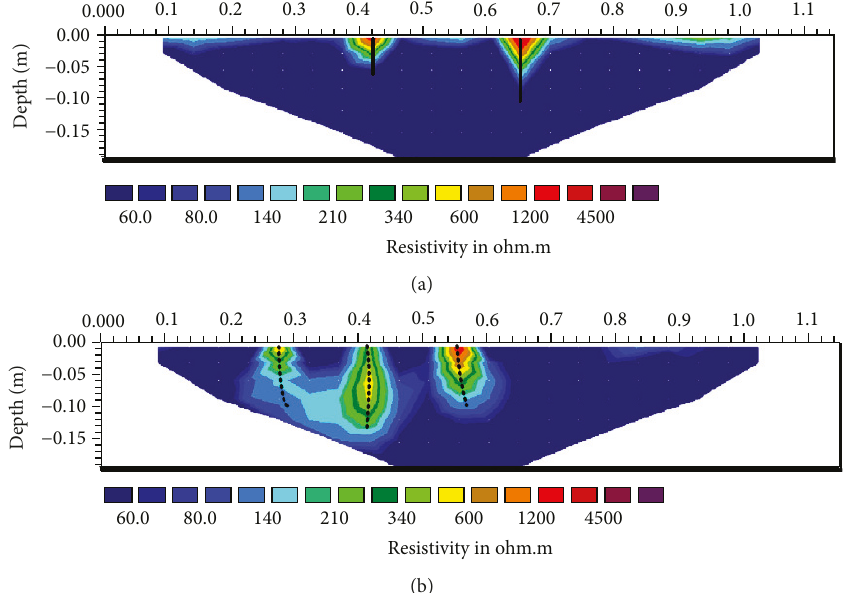
Figure 7: Electrical resistivity image of a concrete beam with cracks [11]: (a) concrete beam with artificial plastic sheets as crack; (b) concrete with cracks being developed from a four-point